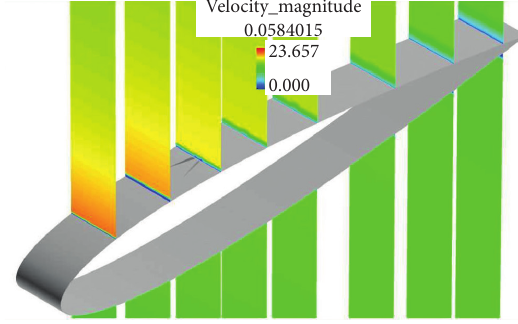
Figure 16. Perspective view of the transverse velocity profiles on the NACA 0015 airfoil with VG in Re c = 2.38 × 10 5 and AoA =